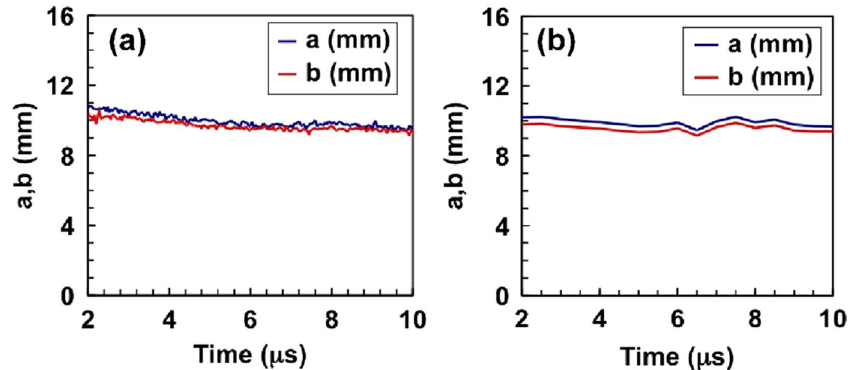
FIG. 10. (Color) Beam radii: (a) 21 cm ( z (cid:6) 152 cm ) and; (b) 27 cm ( z (cid:6) 158 cm ) downstream of the exit of two solenoids as a function of time.